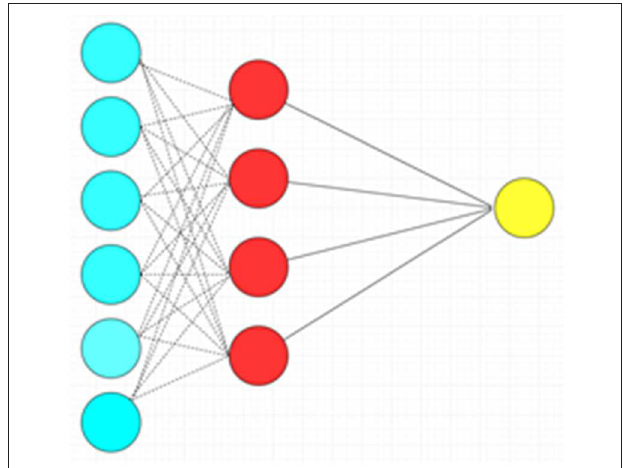
FIGURE 4 | Artificial neural network with a single hidden layer. There is complete connection between layers. Blue circles: Input layer. Red circles: Hidden layer. Yellow circle: Output layer.